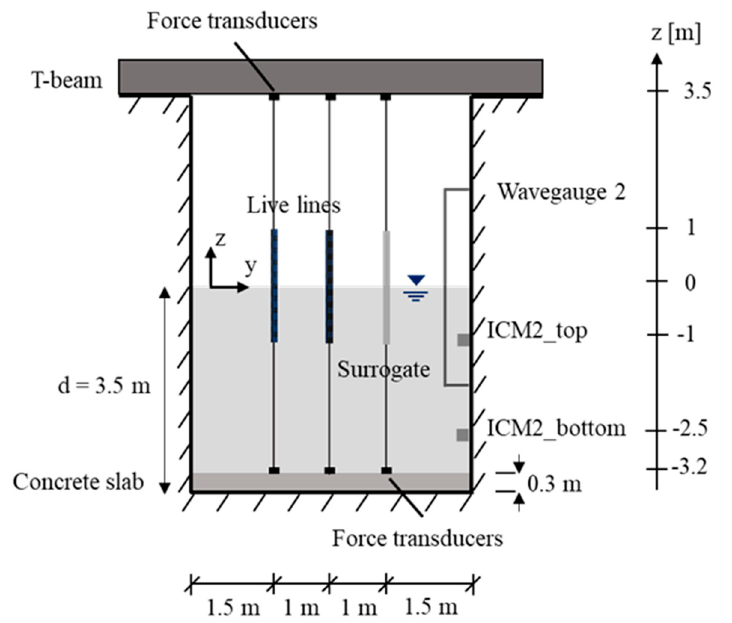
Figure 2. Test rack with live dropper lines, surrogate and measuring equipment (sketch not to